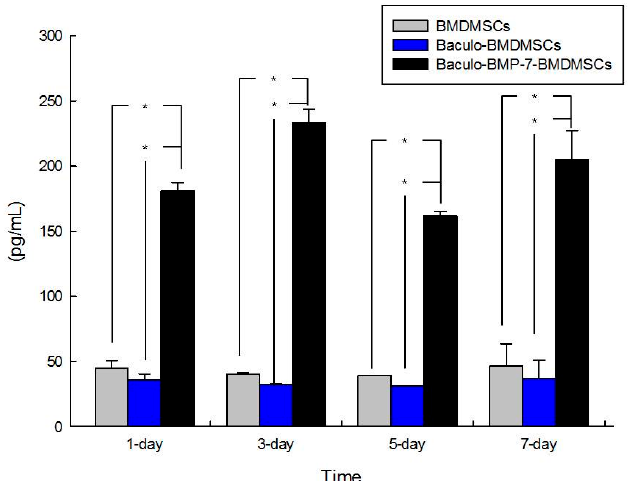
Figure 1. This graph demonstrates the levels of BMP-7 production by bone marrow-derived mesenchymal stem cells (BMDMSCs), Baculo-BMDMSCs, and Baculo-BMP-7-BMDMSCs. Baculo- BMP-7-BMDMSCs secreted significantly more BMP-7 than the other two groups at all the time points. * means a p value< 0.05